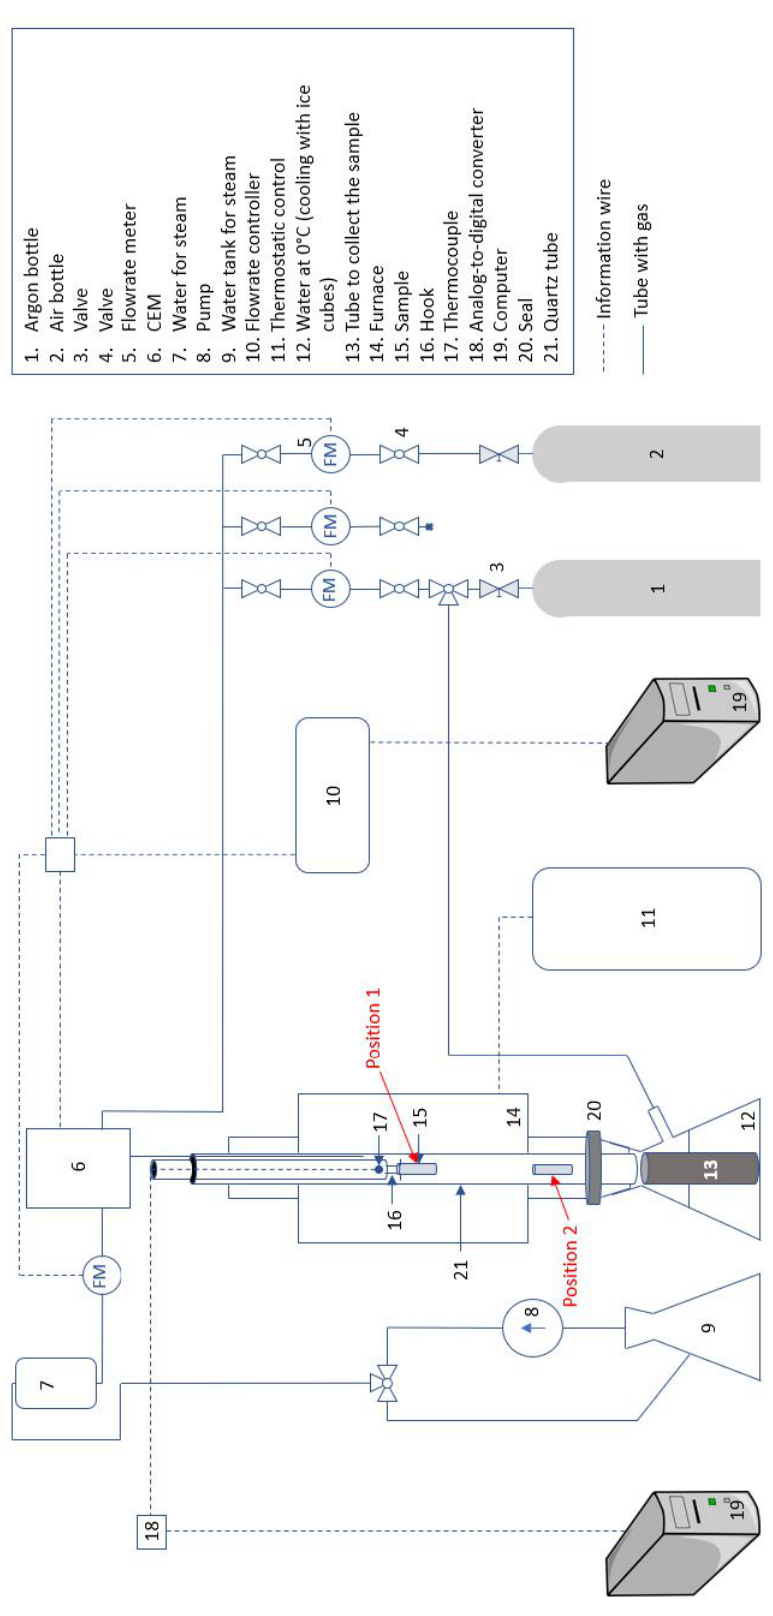
Figure 9. Schematics of the experiment